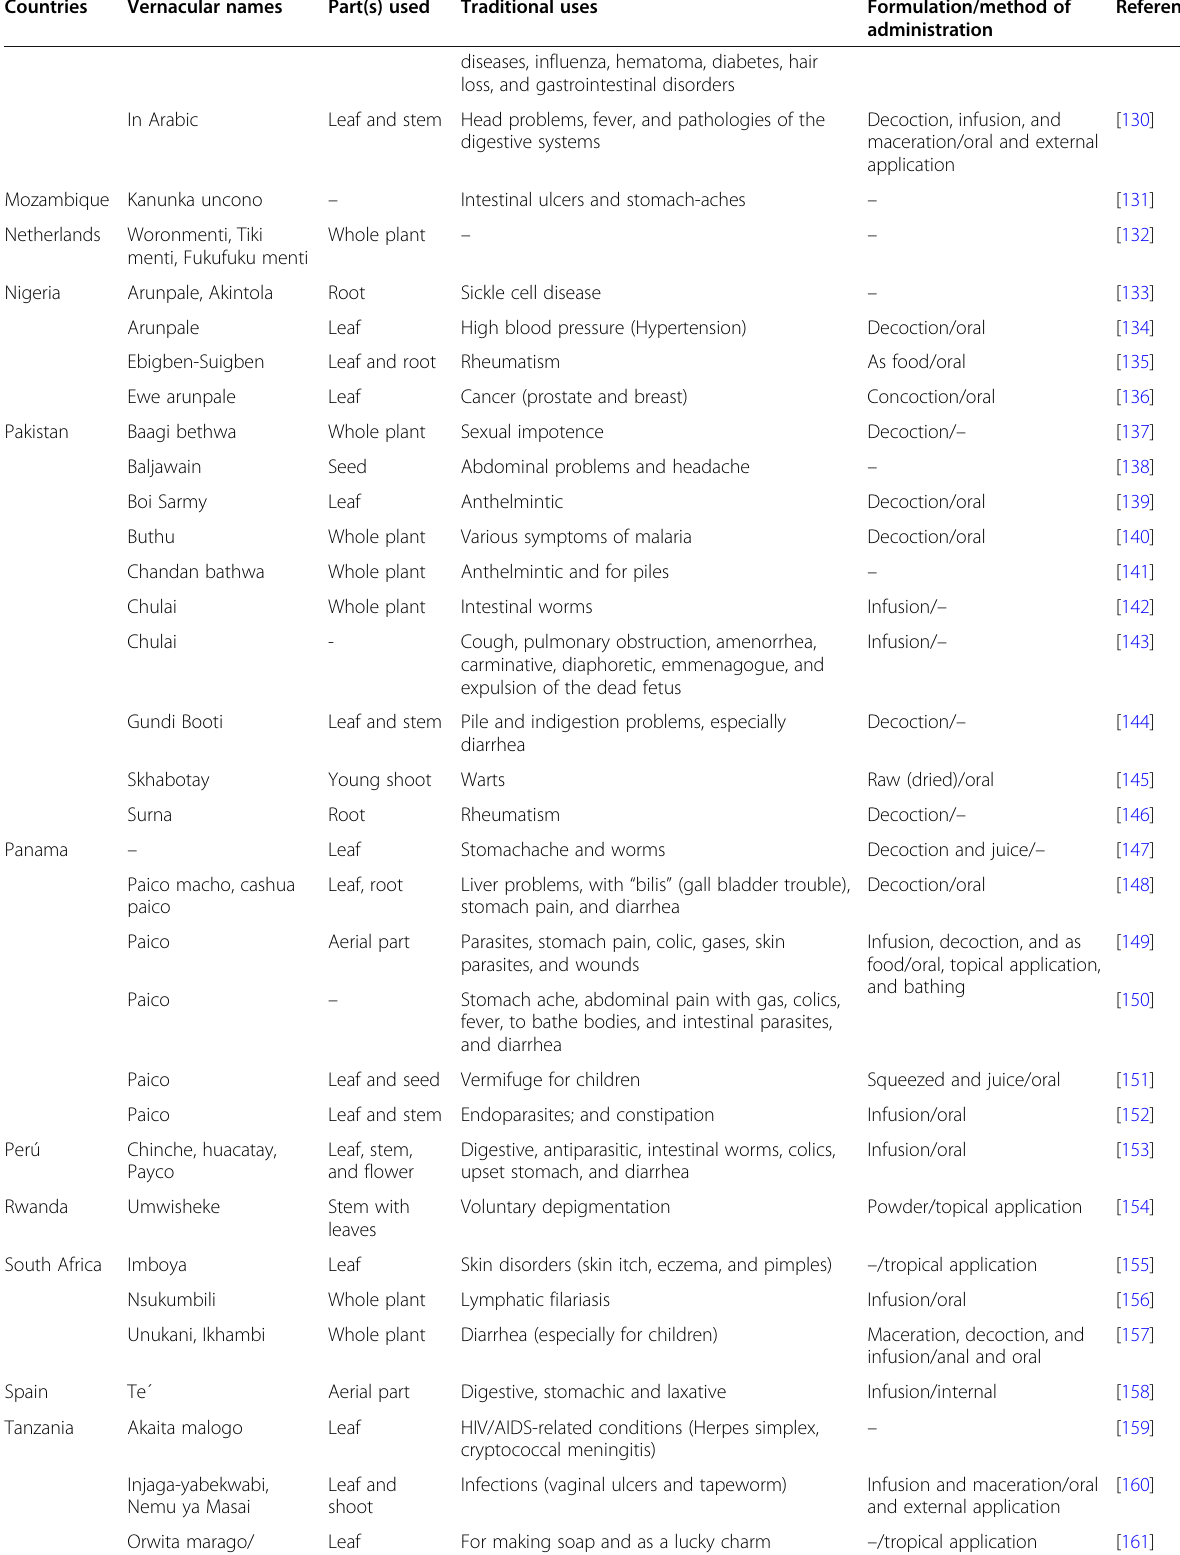
Table 1 Traditional uses of the different parts of C. ambrosioides worldwide (Continued)